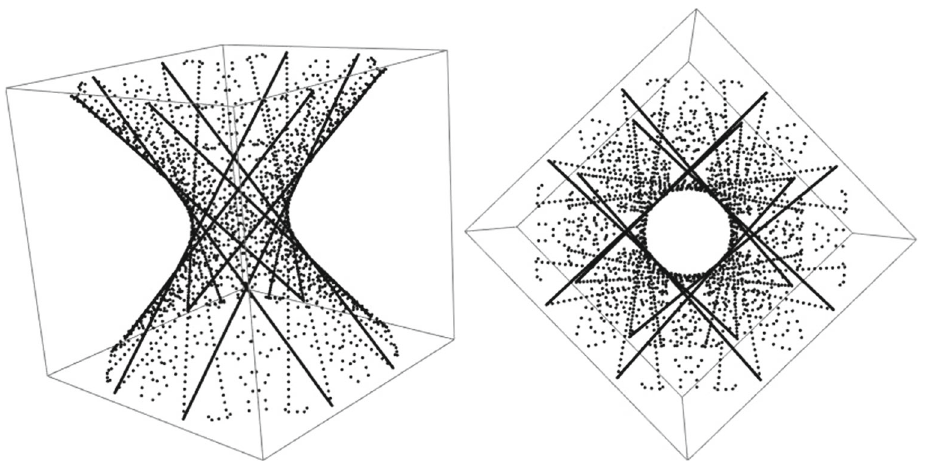
Fig. 1 The rational points on AdS 2 [ p ] -side view and top view, for N = 47 , M = 48 , L =